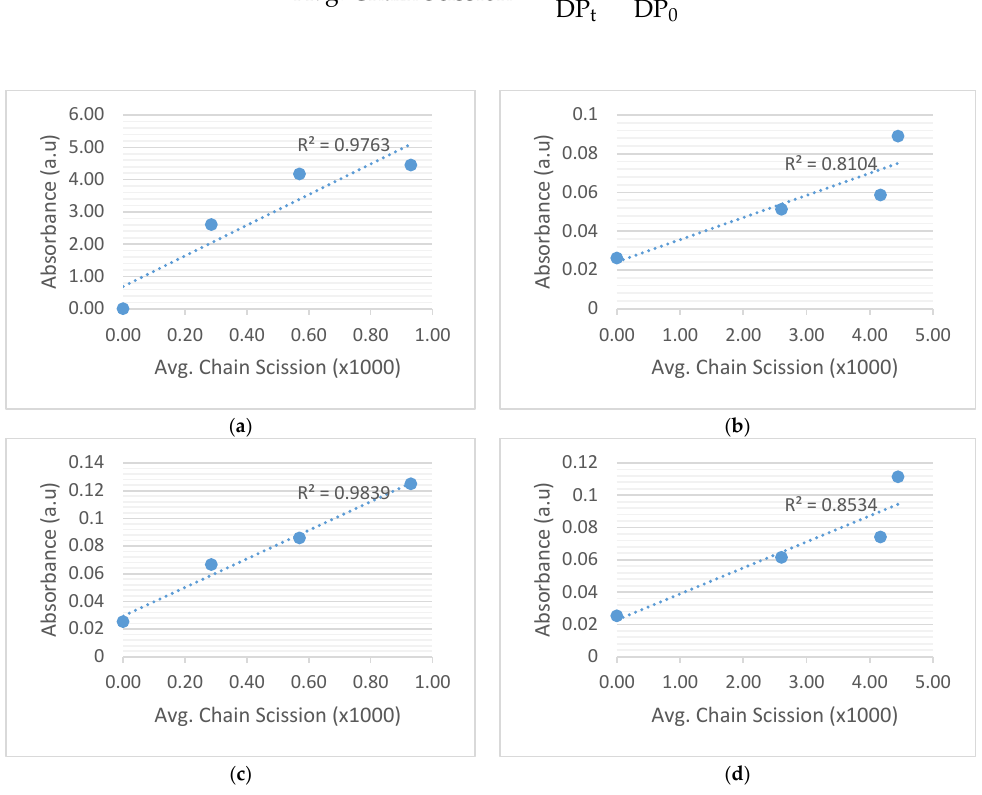
Figure 9. Correlation between average number of chain scission of transformer insulation paper and intensity of peaks absorbance of C–H functional group at aging temperature ( a ) 120 ◦ C (2922 cm − 1 ); ( b ) 150 ◦ C (2922 cm − 1 ); ( c ) 120 ◦ C (2854 cm − 1 ); ( d ) 150 ◦ C (2854 cm − 1